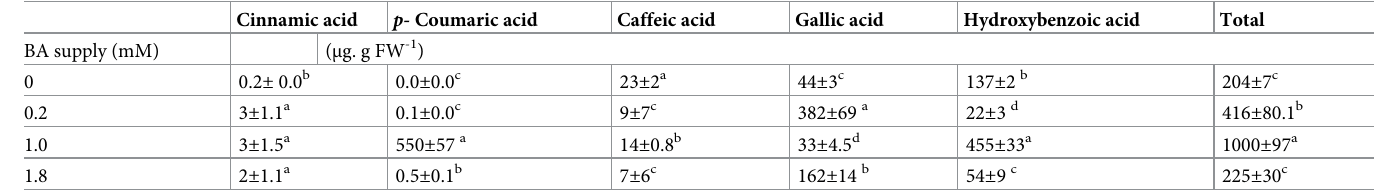
Table 1. Alteration of C . tarraconensis . phenolic acids content in response to various concentration of BA. Data show mean ± SD, n = 3. Different letters show signifi- cant differences at P � 0.05 according to Duncan test.